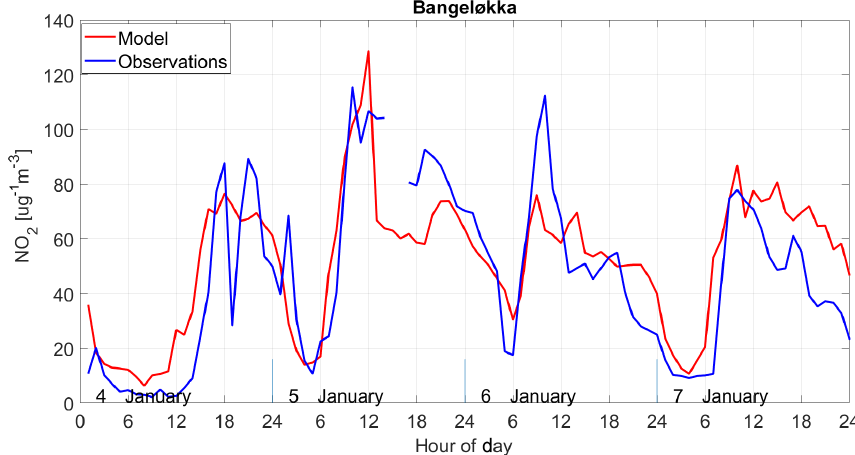
Figure 16. Time series of NO 2 concentrations for the Bangeløkka measuring station in Drammen during a pollution episode lasting from 4 to 7 January 2015. Receptor point concentrations from the model are shown in red, and the observed concentrations are shown in